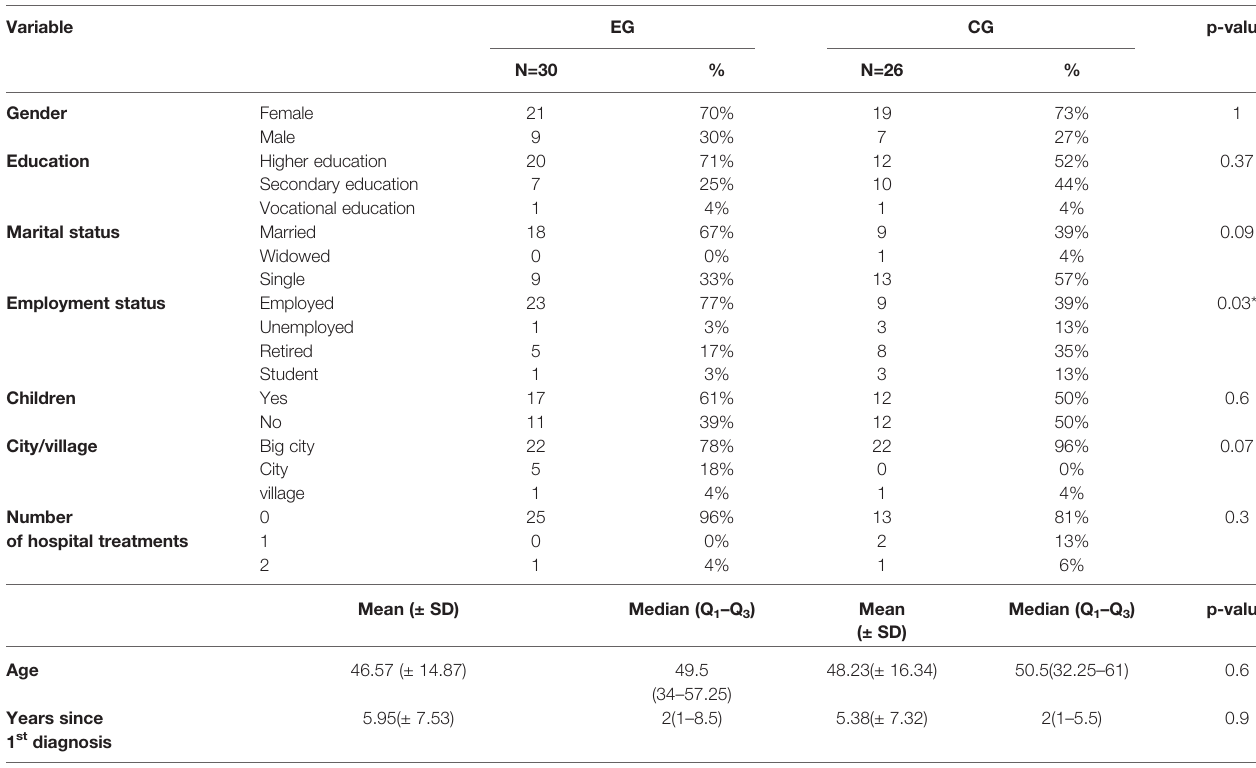
TABLE 1 | Demographical description of the study participants